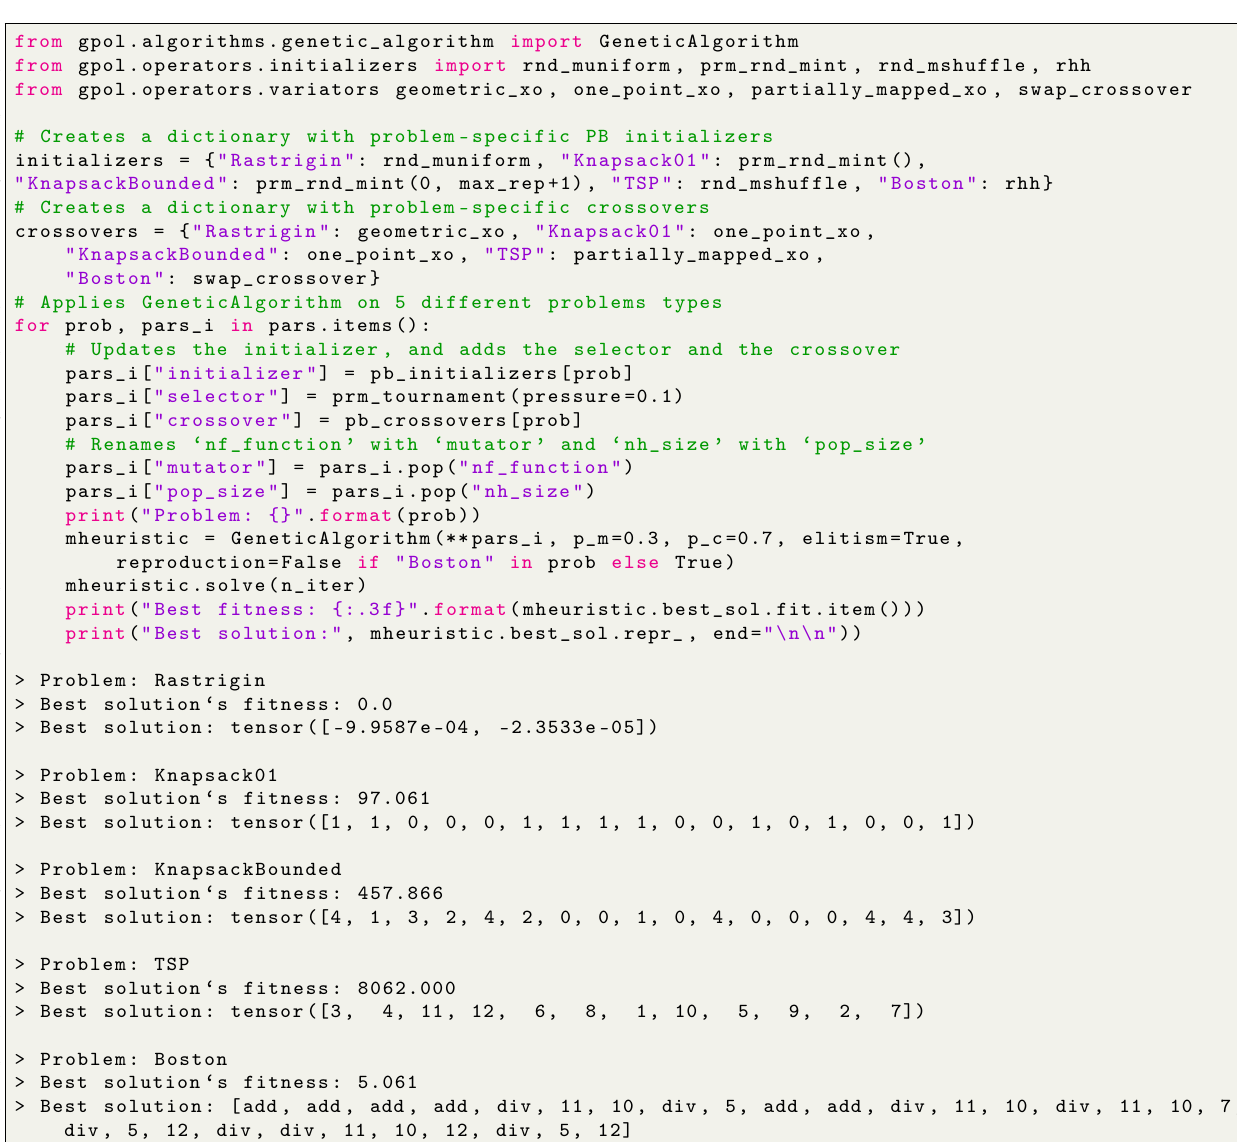
Figure A7. Examples of GeneticAlgorithm being used to solve various